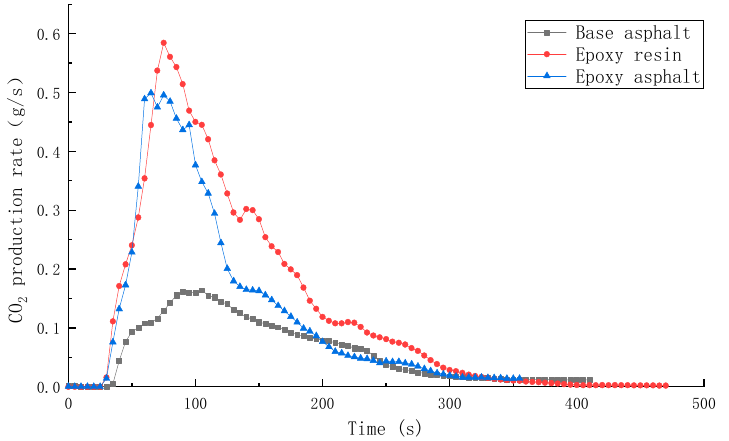
Figure 12. CO 2 production rate (CO 2 P) of different materials.